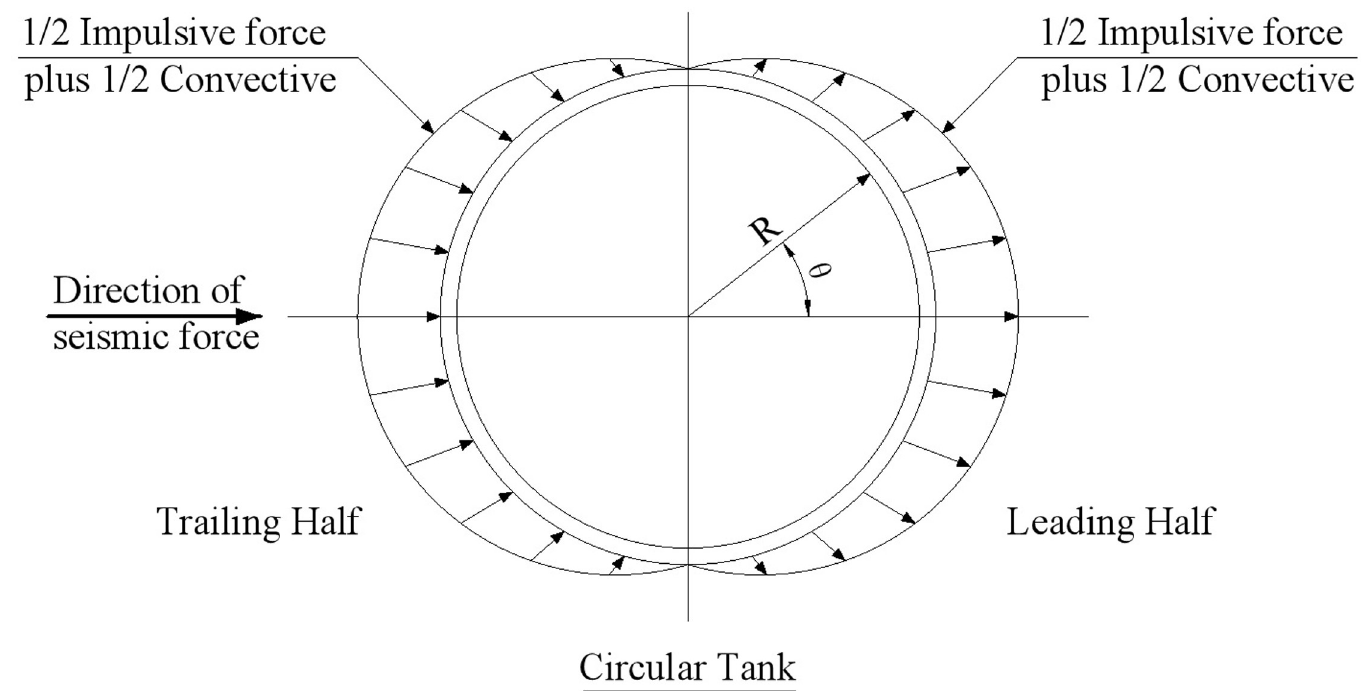
Fig 4. Hydrodynamic pressure distribution of a circular tank in ACI 350.3–01 code.